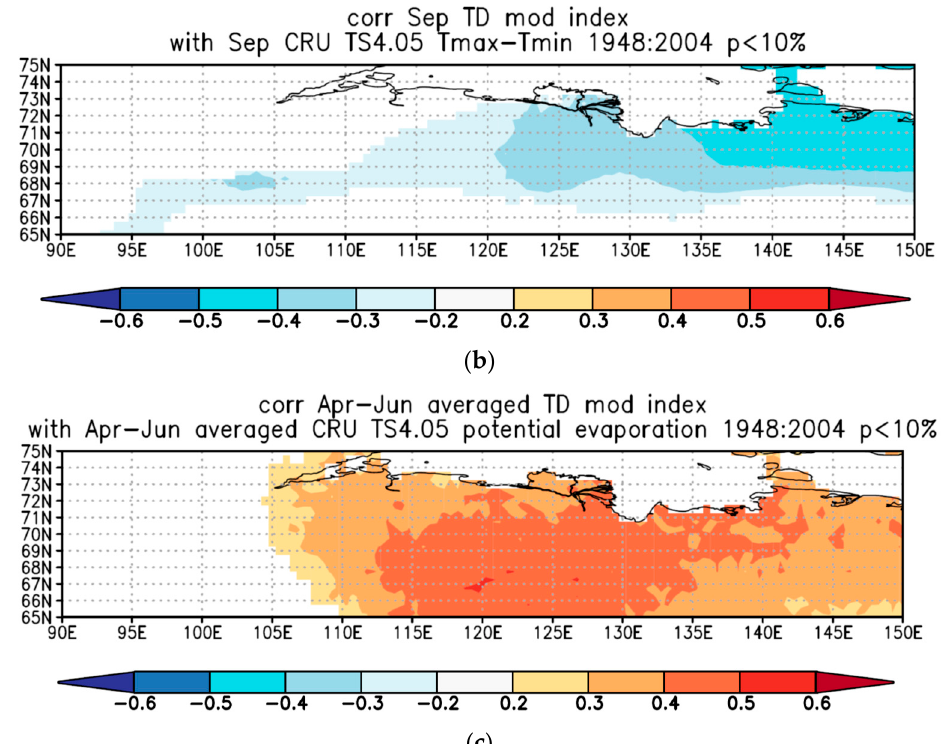
Figure 5. Spatial distribution of correlation coefficients between modelled water fraction of permafrost thaw depth at 20–30 cm from Yakutia (69° N − 148° E) for the period from 1948 to 2004 and differences between maximum and minimum values (Tmax–Tmin) of averaged April–June air temperature ( a ), September air temperature ( b ) and April–June potential evapotranspiration ( c ). Correlation coefficients (r) are presented from negative − 0.6 (violet) to positive 0.6 (red) at the p -value < 0.01.